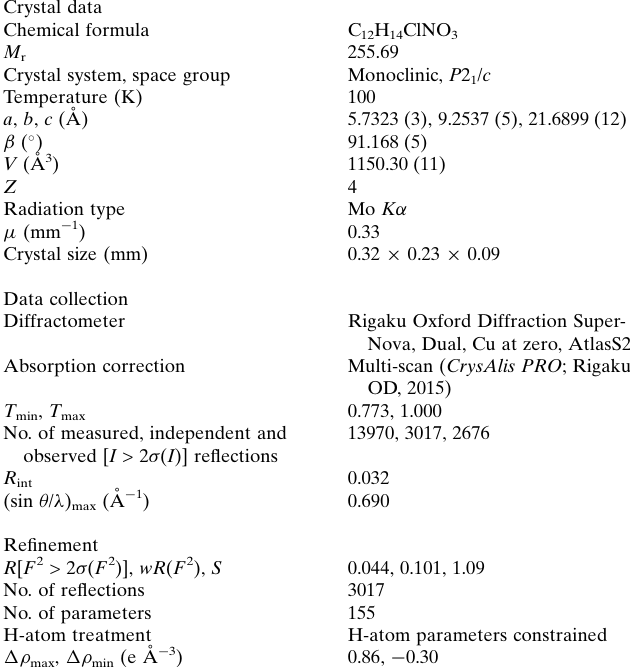
Table 2 Experimental